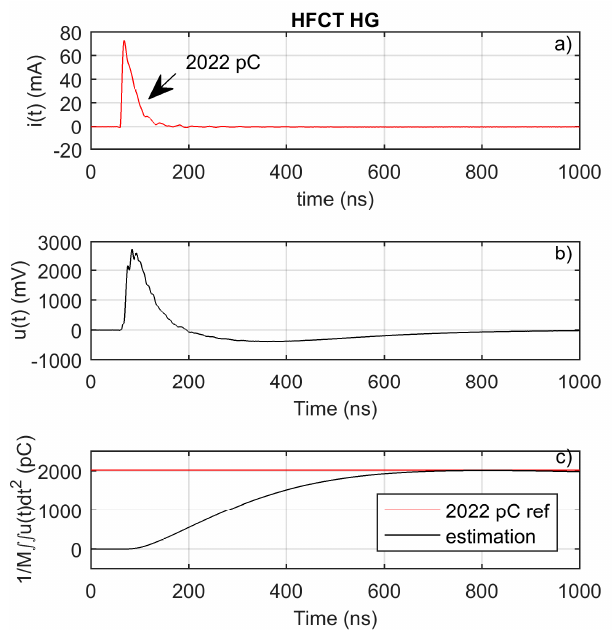
Figure 13. HFCT_HG: ( a ) injected calibrator current pulse; ( b ) measured pulse; ( c ) charge estimation using double integral.